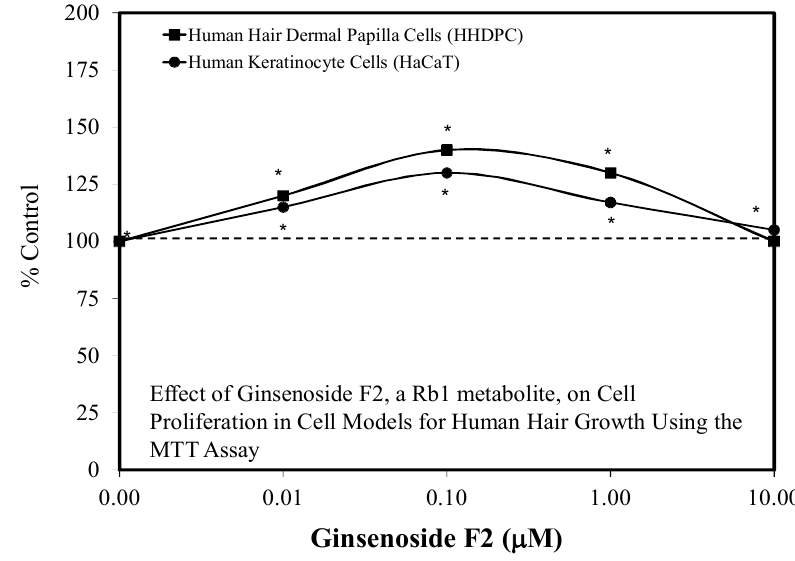
Figure 22. Effect of ginsenoside F2, a Rb1 metabolite, on cell proliferation in cell models for human hair growth using the MTT assay (Source: [93]). Each * represent statistical significance for a data point.